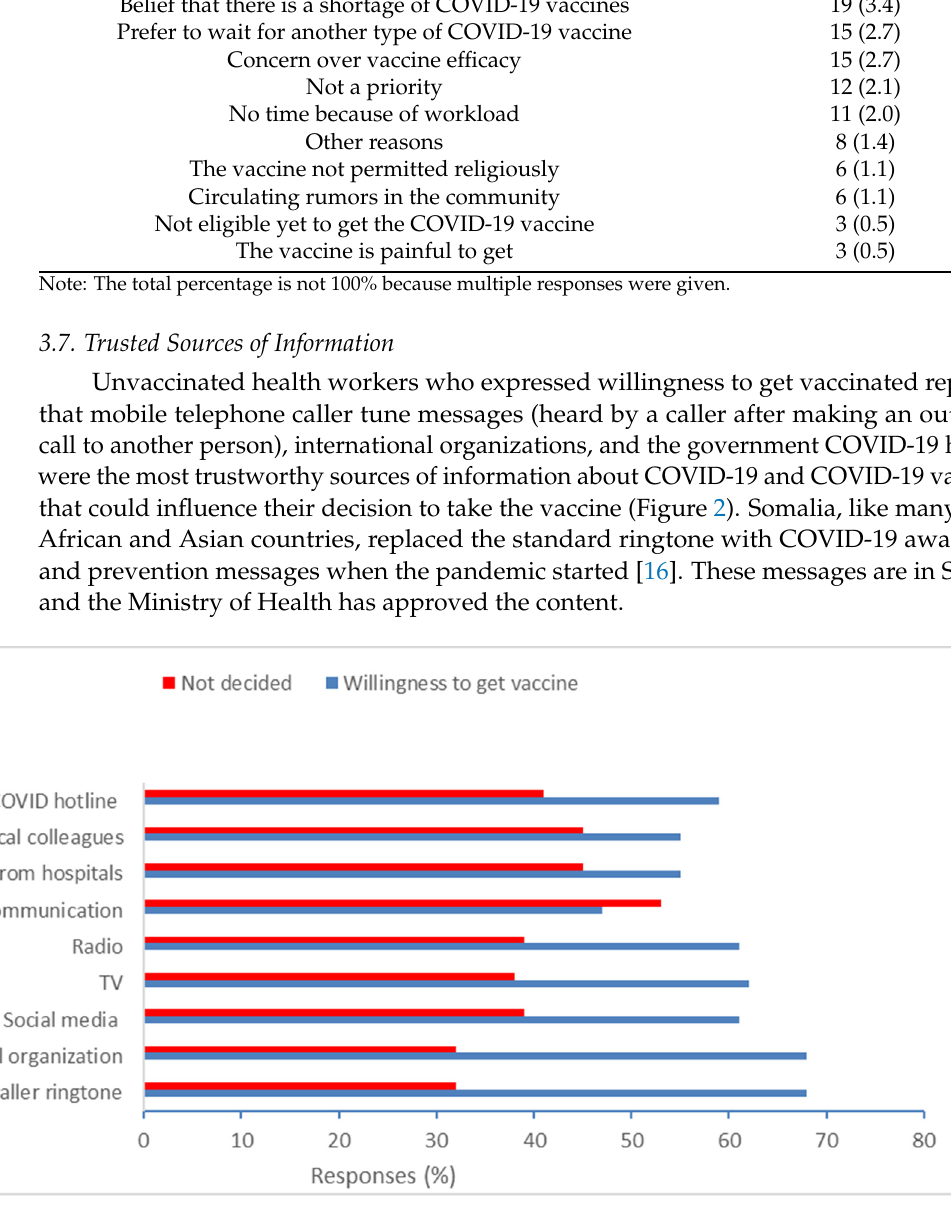
Figure 2. Trusted sources of information on COVID-19 among unvaccinated Somali health workers, by willingness to get vaccinated. Note: Social media included Facebook, Twitter, Snapchat, and TikTok.